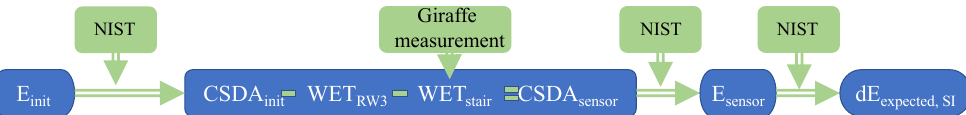
Figure 8. Calculation of the expected deposited energy in the sensor using the NIST database, the WET of the RW3 plates, and the WET of the corresponding ROI for the staircase